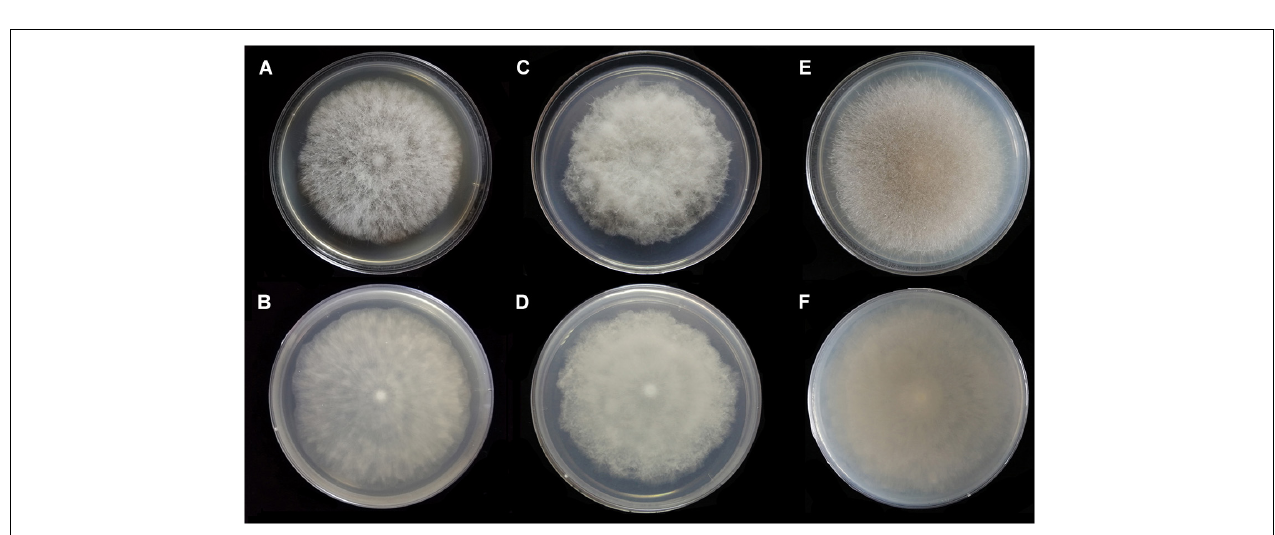
FIGURE 7 | Colonies of Absidia medulla CGMCC 3.16037 at 27 ◦ C after 5 days on MEA (A) obverse, (B) reverse; after 6 days on SMA (C) obverse, (D) reverse; after 5 days on PDA (E) obverse, and (F) reverse.